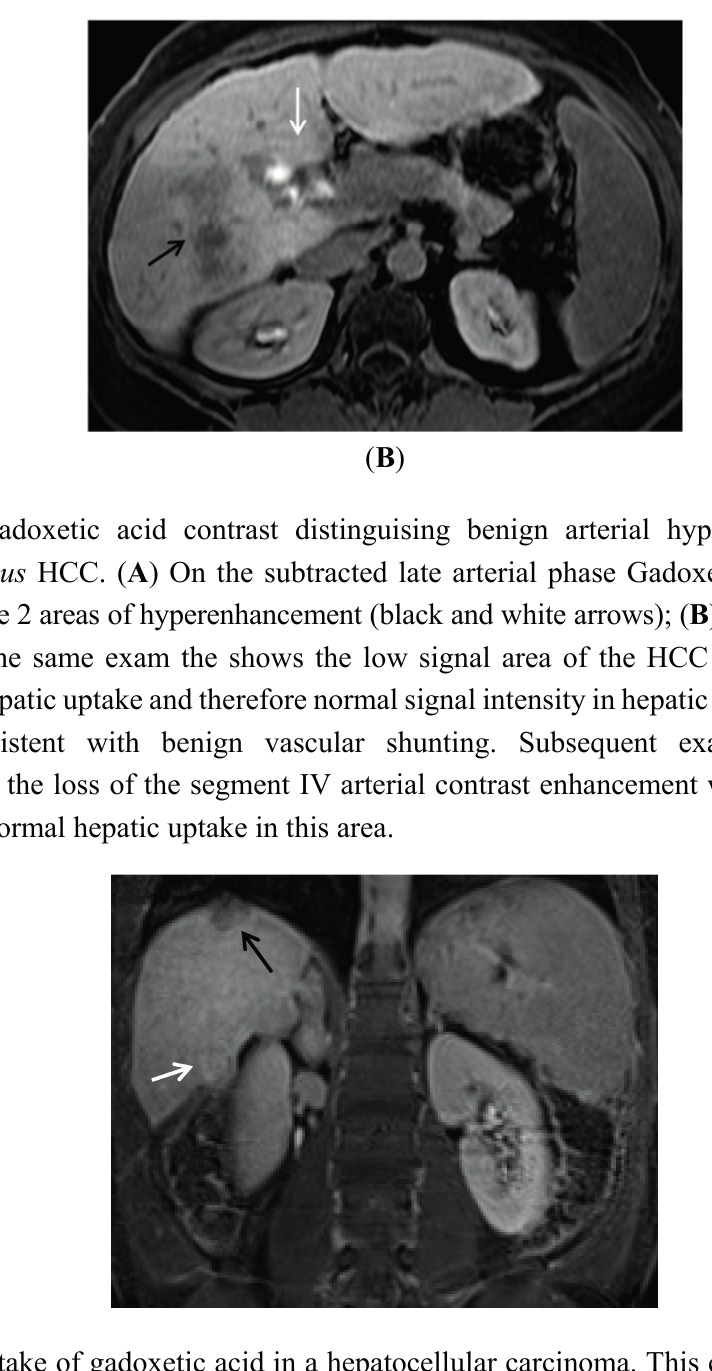
Figure 5. Uptake of gadoxetic acid in a hepatocellular carcinoma. This coronal image was obtained 15 min after intravenous injection of Gadoxetic acid. (Note that this exam was obtained by a combination contrast technique. This was obtained by first injecting an extracellular gadolinium agent and imaging through the equilibrium phase. This was followed by Gadoxetic acid injection with subsequent hepatobiliary imaging at 15 min.) There are two HCC’s present on this image. The lesion at the dome (black arrow) demonstrates a well circumscribed, hypointense area compatible with the mass without normally functioning hepatocytes. This mass had arterial hyperenhancement and delayed phase washout. These findings are all compatible with hepatocellular carcinoma. The lesion in segment 5–6 (white arrow) is also a hepatocellular carcinoma (same patient as in